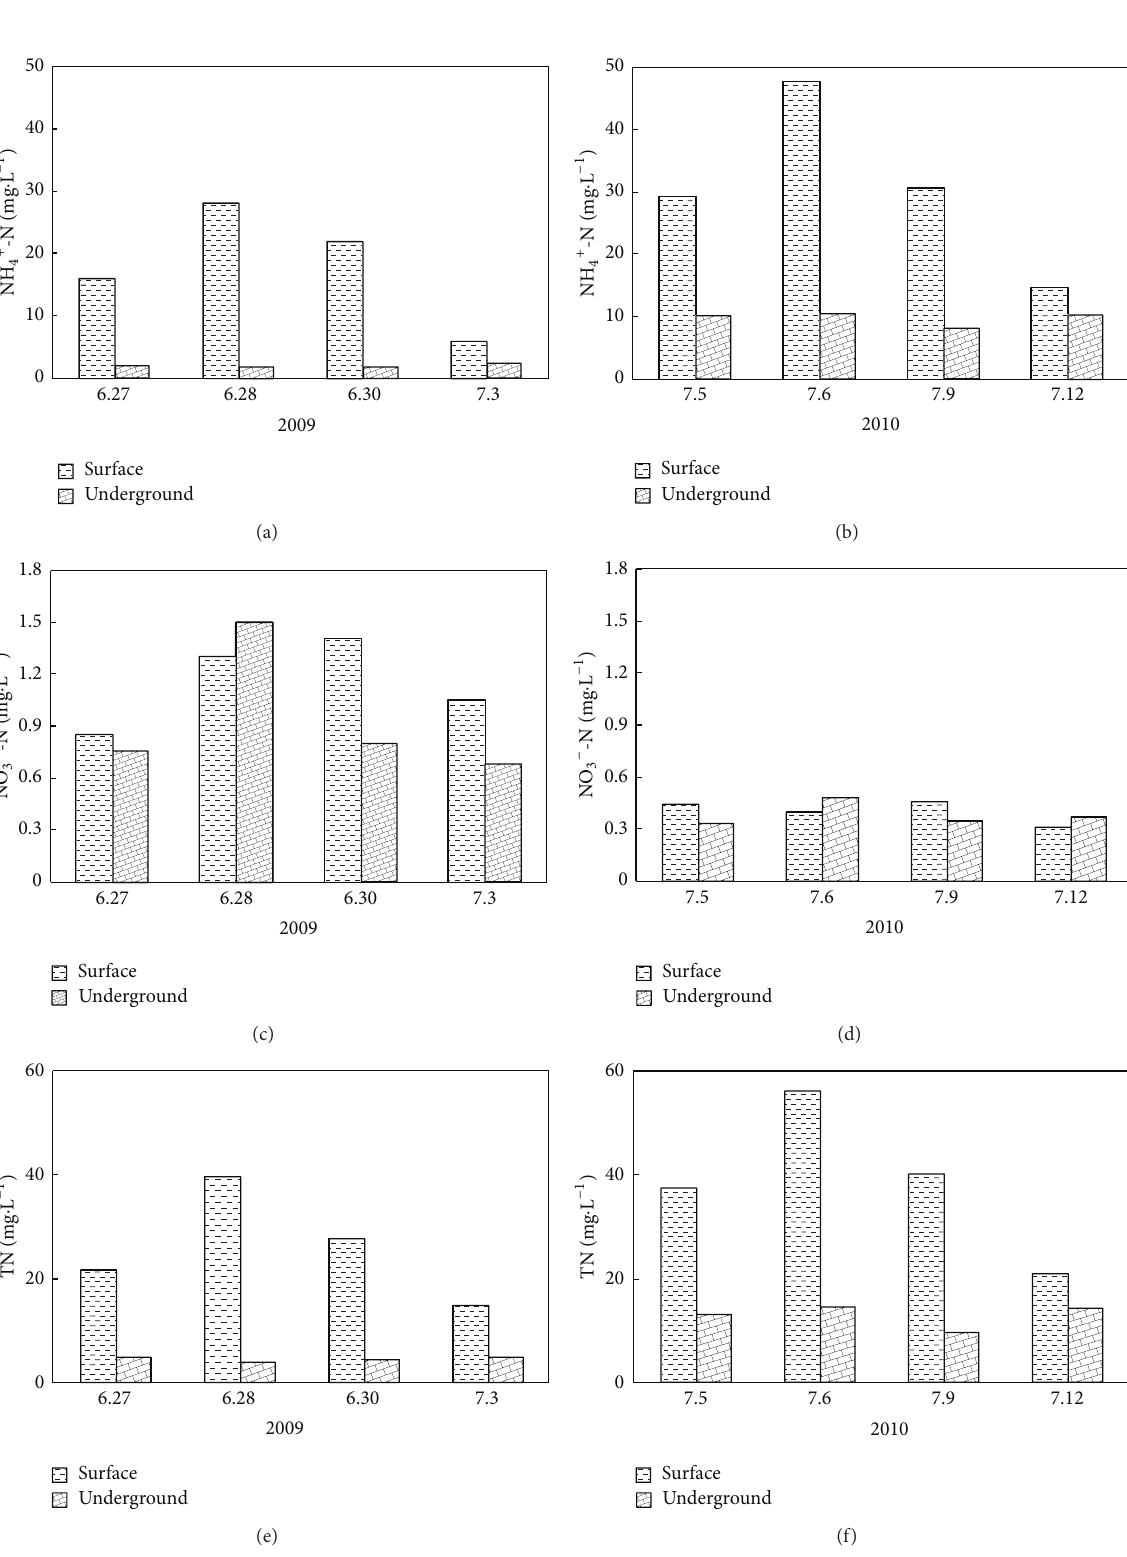
Figure 2: The change of the concentration of NH 4+ -N, NO 3− -N, and TN after fertilization at tillering stage in 2009 and